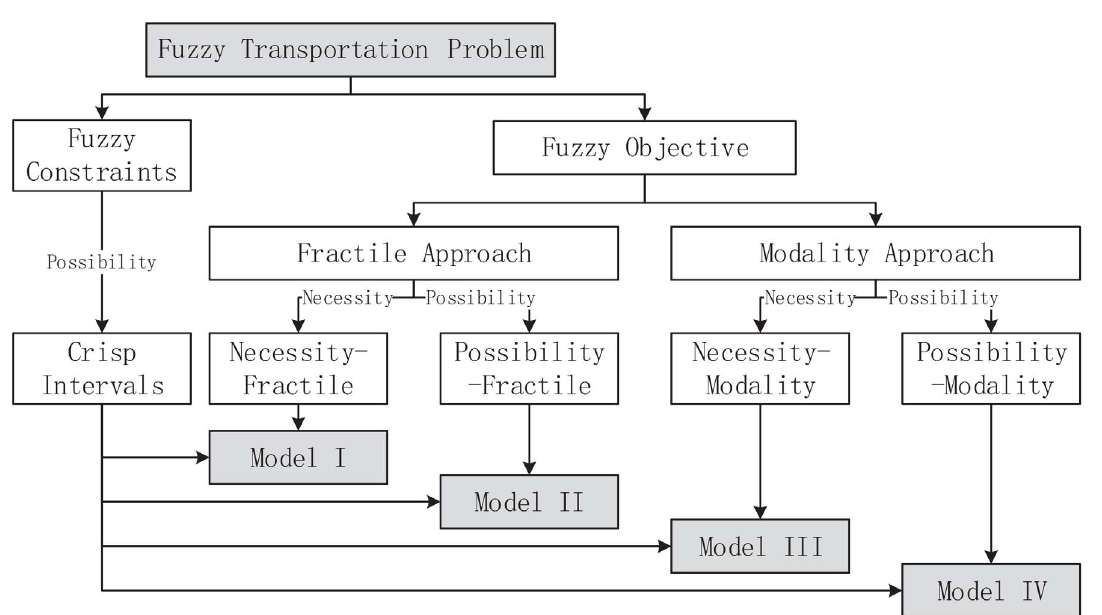
Figure 2. Framework of defuzzifying FTP.